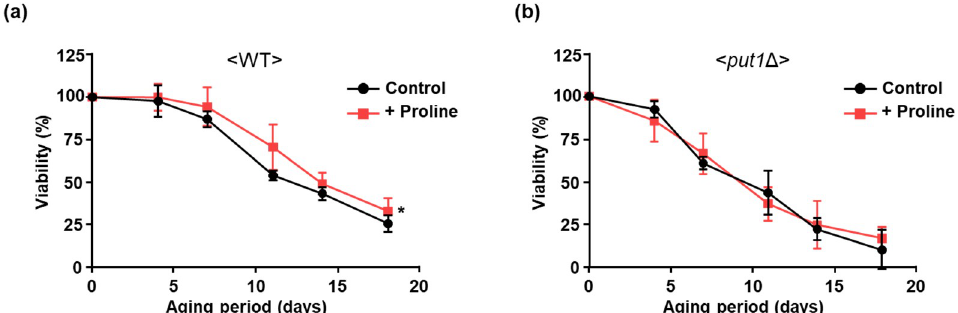
Figure 3. Effect of proline supplement on longevity. Chronological survival curves of WT ( a ) and put1 Δ ( b ) cells supplemented with proline (+ Proline) were determined by counting the number of colony-forming units. Proline (100 µM) was added to medium every 5 days. Data are presented as means ± SD ( n = 5) and statistical significance was determined by two-way ANOVA with Tukey’s test. * p < 0.05, vs. non-treated control (Control).